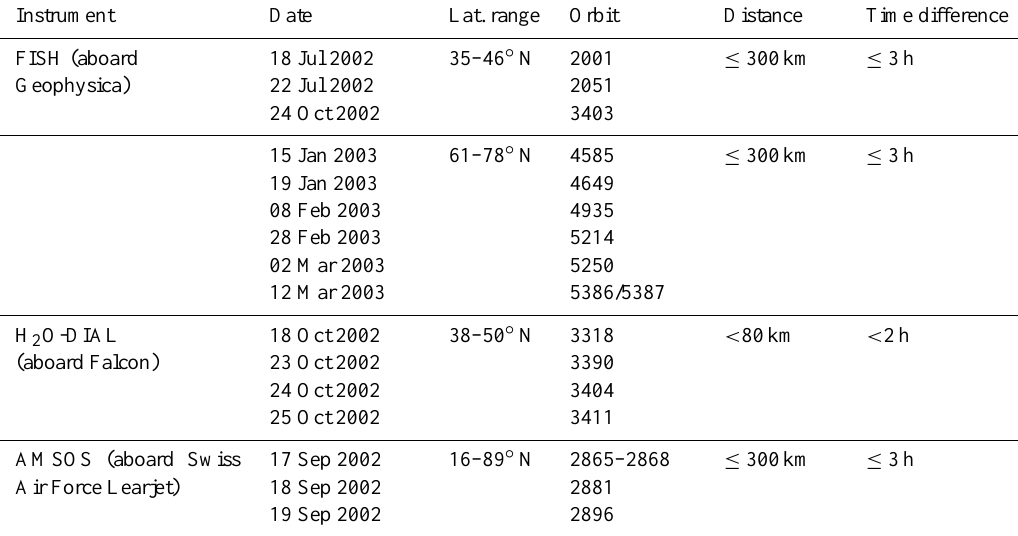
Fig. 3. Hydrogen budget of all comparisons between MIPAS-E and MIPAS-B (left panel) together with absolute differences (right panel) and combined precision (dotted lines) and total errors (dashed lines). For comparison, Arctic winter balloon-borne observations (solid grey bar) performed by Engel et al. (1996) and aircraft measurements (solid dark grey bar) carried out by Herman et al. (2002) are also shown.